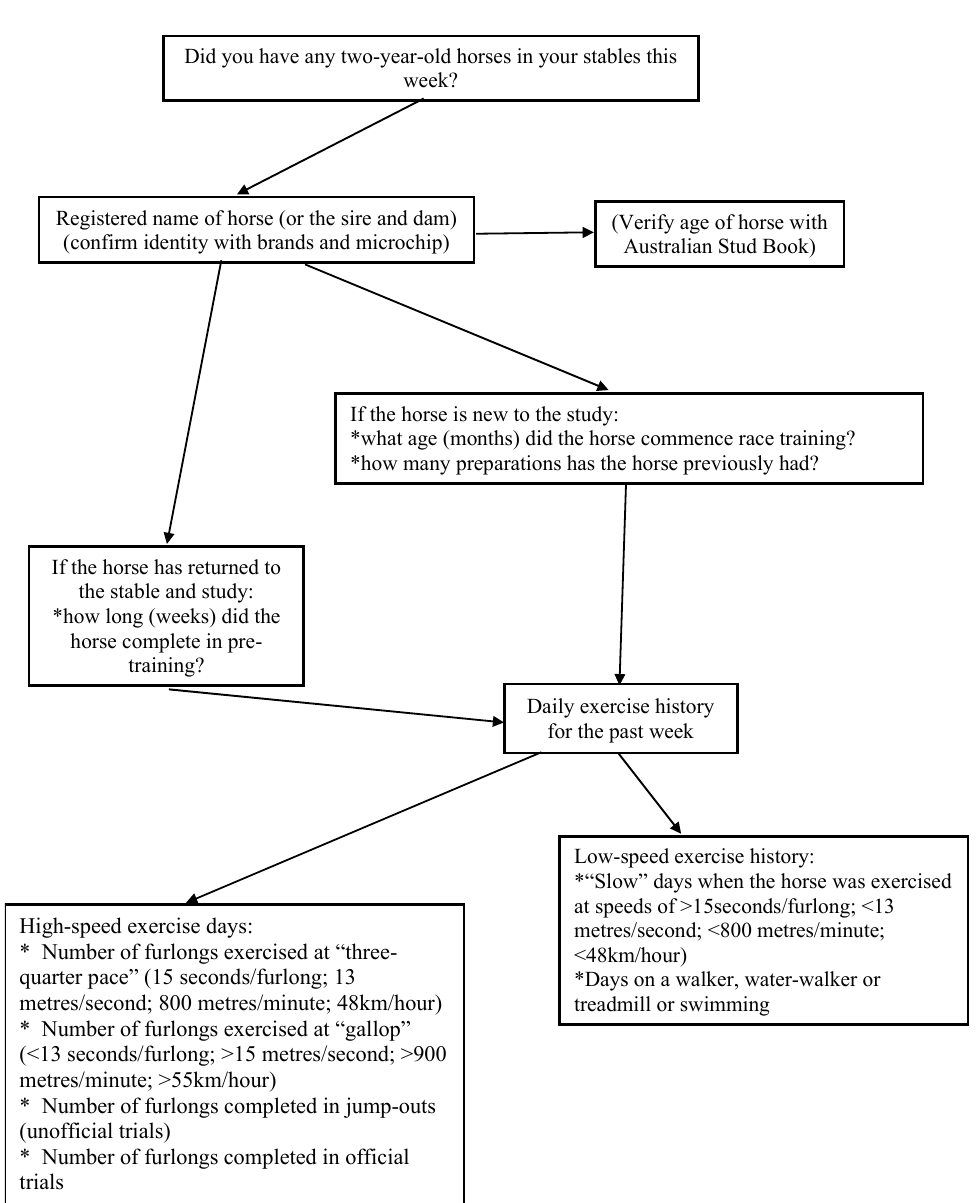
Figure A1. The personal structured interview used to collect detailed exercise data for two-year-old thoroughbred racehorses in Queensland, Australia.